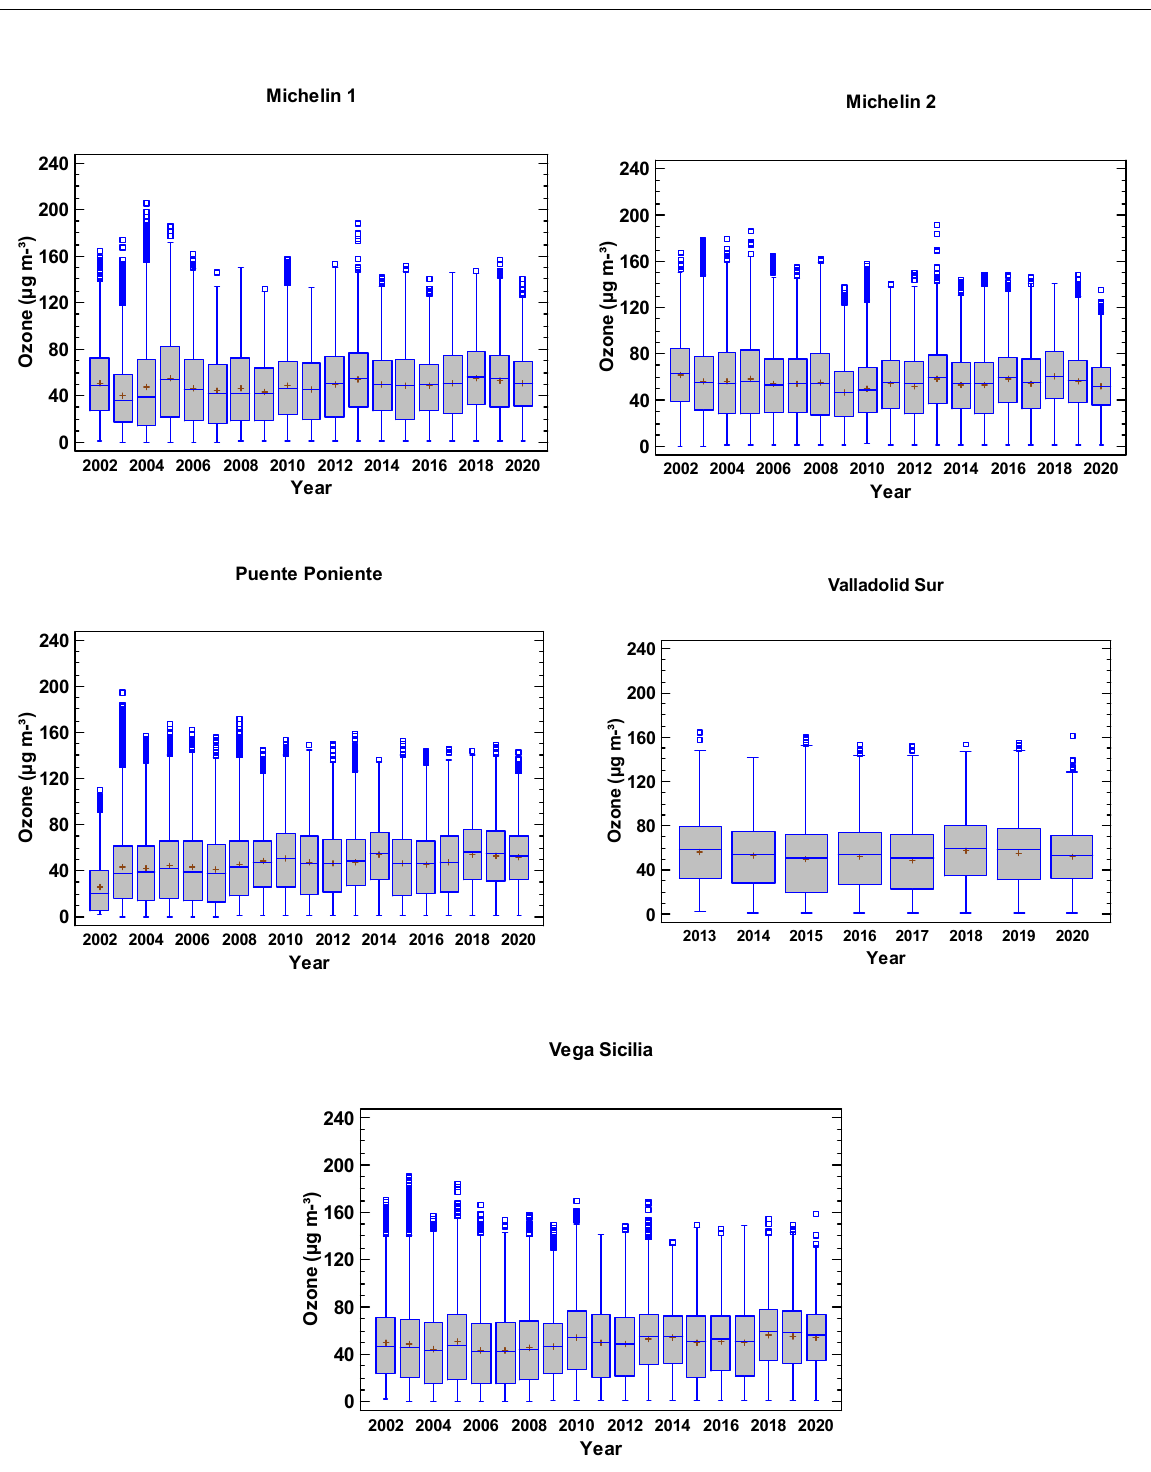
Figure 2. Yearly evolution of ozone concentrations at each measuring station in the study period.